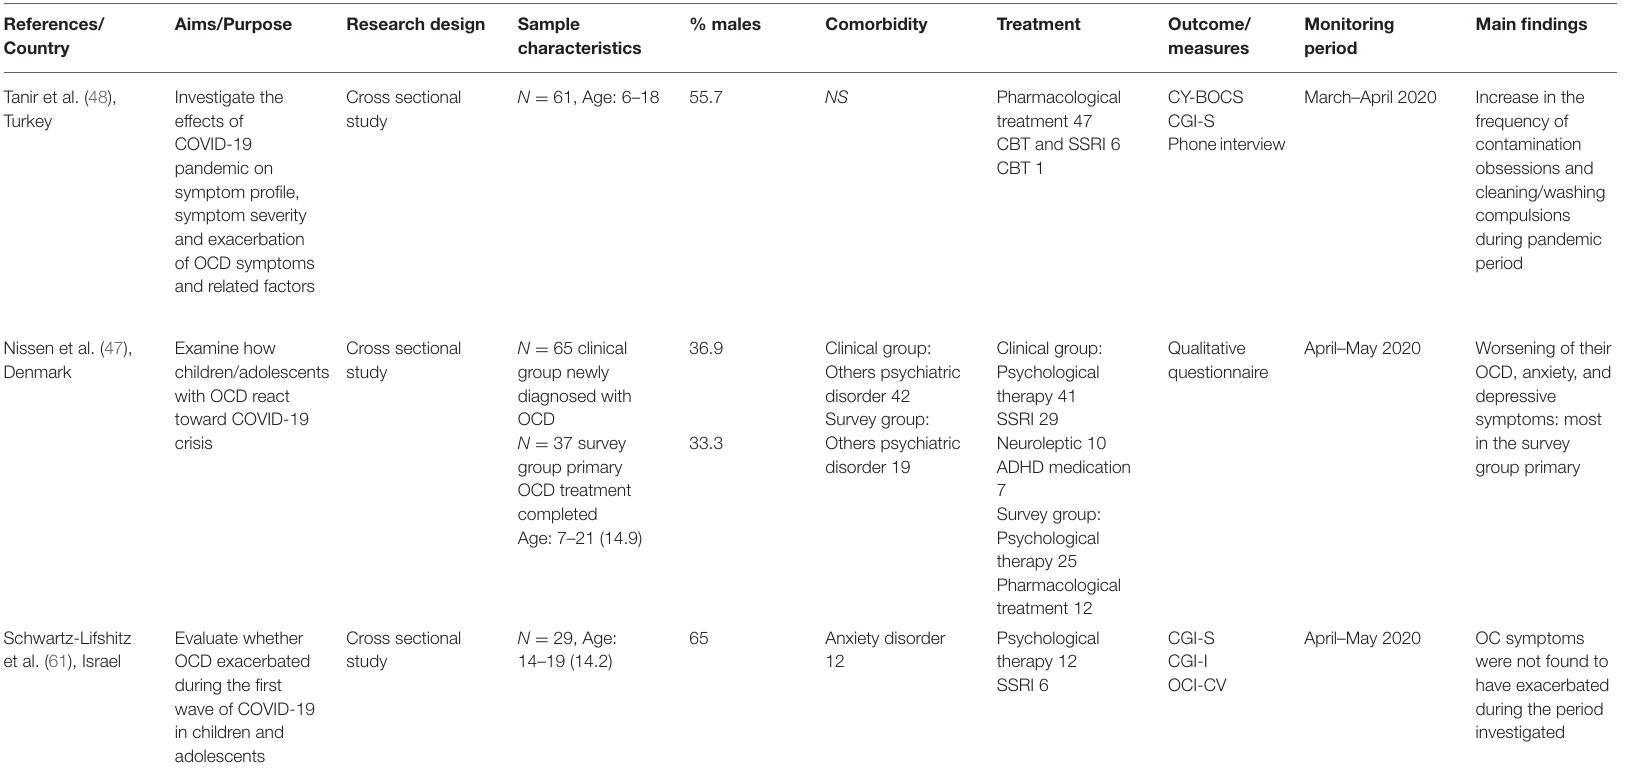
TABLE 2 | Studies among sample of children and